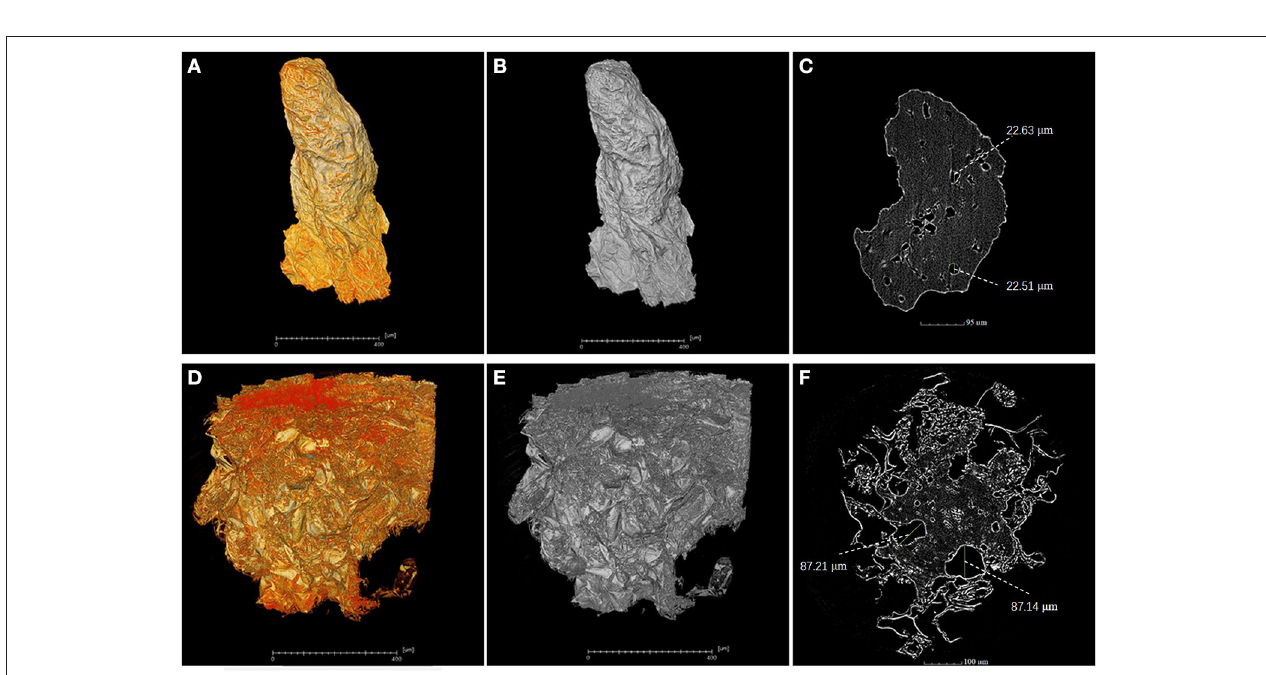
FIGURE 7 | High-resolution analysis of flesh microstructure of “Akizuki” fruit. (A,B) Yellow and gray reconstructed 3D images of flesh from the MRA (middle-risk area with cork spot) of the healthy fruit, respectively. (C) Segment of the X-ray scanning of the healthy fruit flesh. (D,E) Yellow and gray reconstructed 3D images of flesh from the MRA of cork spotted fruit, respectively. (F) Segment of the X-ray scanning of the cork spotted fruit flesh.